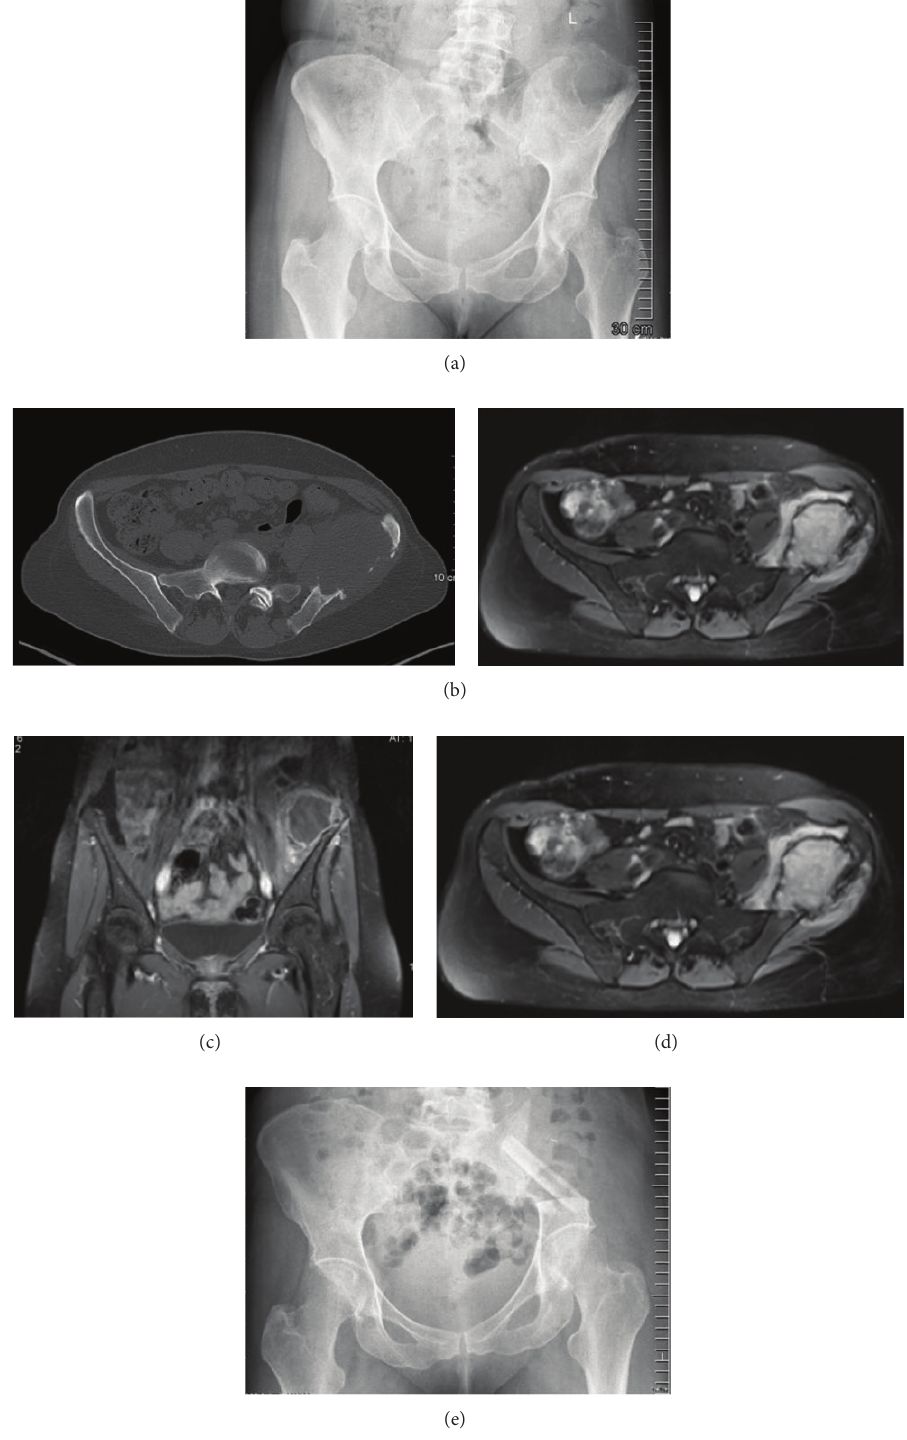
Figure 2: (a) Anteroposterior radiograph of the pelvis, showing a large osteolytic lesion of the left iliac bone (synovial sarcoma). (b) CT scan of the same patient showing the size of the tumor. Notably is the lack of matrix or calcification inside the tumor. (c) and (d) MRI scan of the same patient showing the intra- and extrapelvine size. (e) Postoperative X-ray after P1 resection and pelvic reconstruction stabilised with an autologous nonvascularised fibular